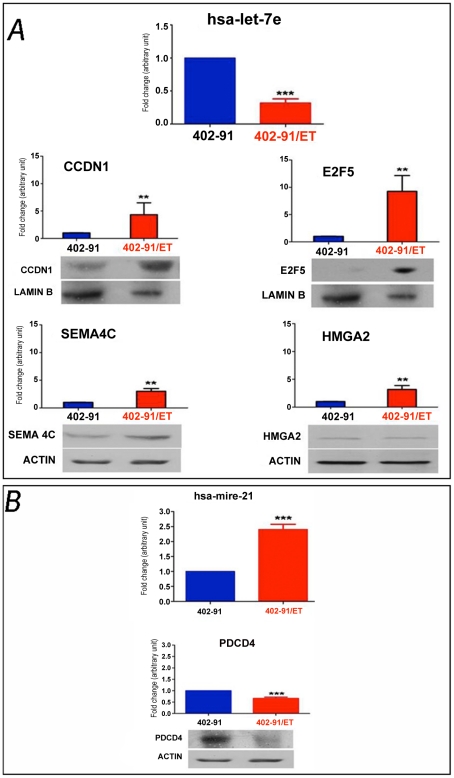
Signature validation of miRNA-mRNA and proteins found differentially expressed between 402-91/ET and 402-91 cell line.
Panel A. qRT-PCR and Western blot analysis showing differences in the expression levels of let-7e and its downstream targets (CCDN1, E2F5, SEMA4C, HMGA1 and HMGA2). Panel B. qRT-PCR and Western blot for miR-21 and its downstream target, PDCD4. qRT-PCR data are the mean of three independent experiments performed in triplicate and calculated with the 2−ΔΔCt method as described in the material and method section. The control 402-91 cells values are arbitrarily set as 1. Bars are +/− SD. * is significant with p<0.05, ** p<0.01, ***p<0.001, as assessed with Student T-test. Western blot is representative of at least two independent experiments.